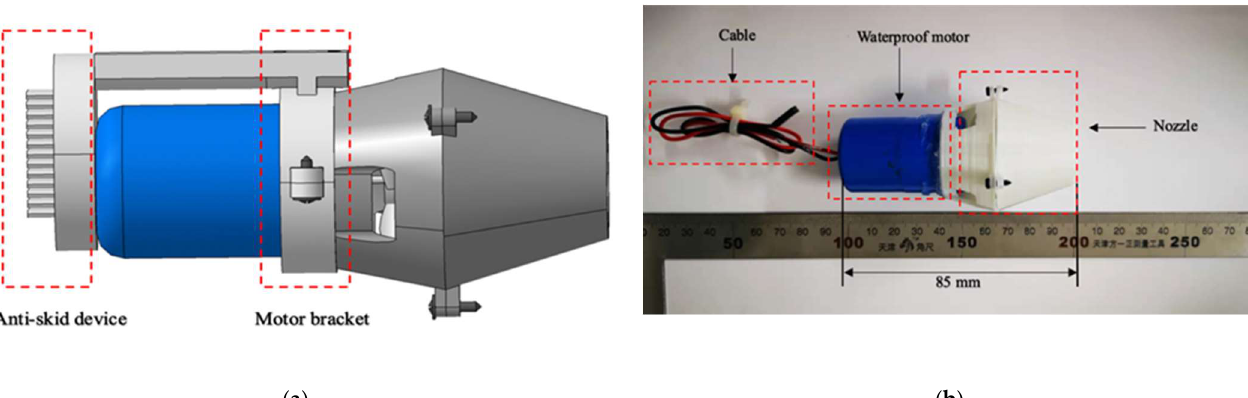
Figure 6. Overall structure of the water jet. ( a ) 3D mechanical structure; ( b ) Overall dimensions.